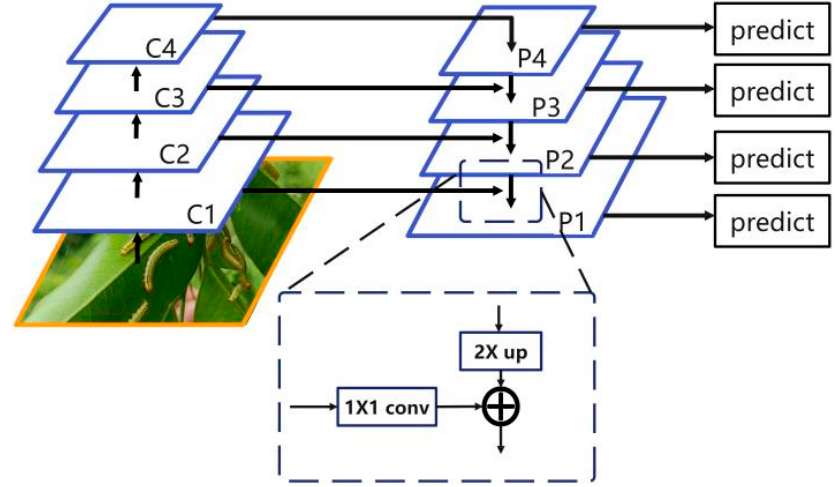
Figure 4. The network structure of FPN.